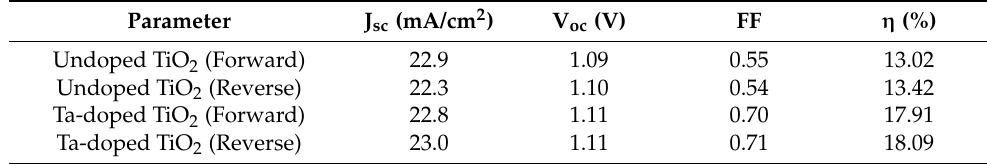
Table 3. Performance of PSCs measured in the reverse and forward